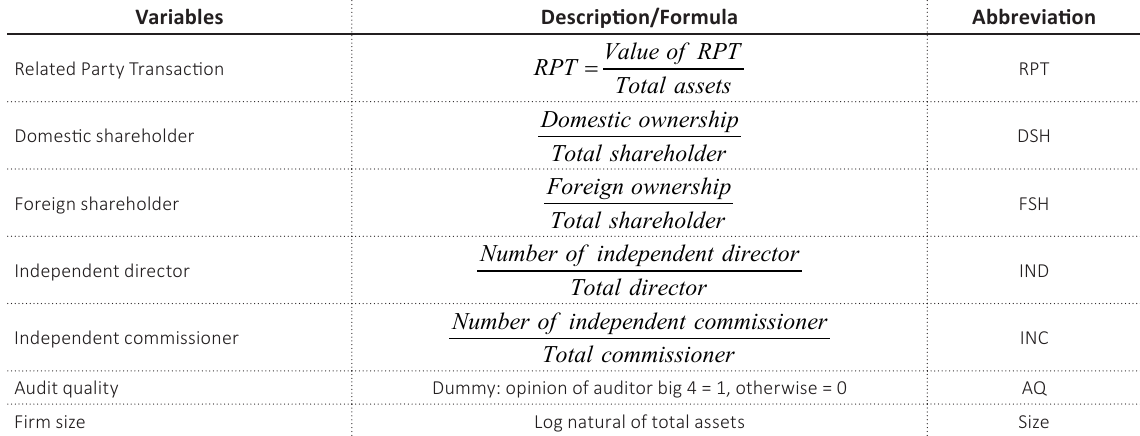
Table 1. Description of